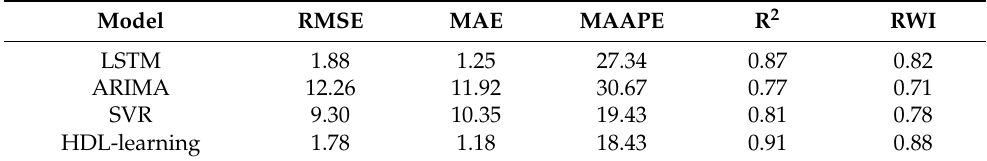
Table 1. Performance comparison of different models in a single station